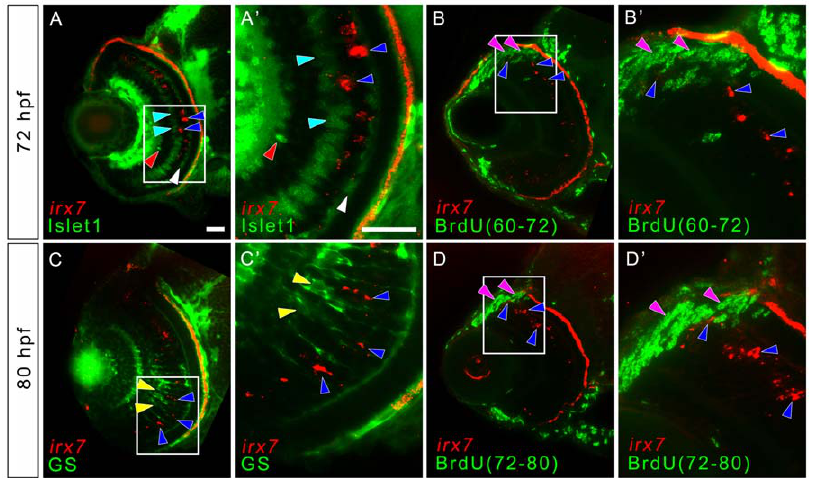
Figure 2. Irx7 expresses in non-proliferative cells that are likely to be undifferentiated precursors in mature retina. To detect for the co-localization of irx7 and ACs, BCs, HCs, MCs and proliferative cells in the more differentiated part of the WT retina, in situ hybridization of irx7 was conducted in conjunction with immunostaining of anti-Islet1 for ACs, BCs and HCs, anti-GS for MCs and anti-BrdU for proliferative cells. (A) irx7 in situ hybridization with anti-Islet1 immunostaining at 72 hpf. The blue arrowheads indicate the irx7 + cells (red colour) in the retina, while the red, cyan and white arrowheads indicate ACs, BCs and HCs respectively (all in green colour). (A 9 ) The magnified view of the white box in (A). (B and D) The retina of embryos treated with BrdU from 60 to 72 hpf and 72 to 80 hpf respectively. The blue arrowheads indicate irx7 + cells (red colour), while the pink arrowheads indicate BrdU + cells (green colour). (B 9 and D 9 ) The magnified view of the white box in (B and D) respectively. (C) irx7 in situ hybridization with anti-GS immunostaining at 80 hpf. The blue arrowheads indicate the irx7 + cells (red colour), while the yellow arrowheads indicate MCs (green colour). (C 9 ) The magnified view of the white box in (C). Lateral is to the left and dorsal is up for all sections. Note that the RPE layer also showed red fluorescence but that was not a real signal. It was an artifact of the pigmentation in RPE. Since the images of the in situ hybridization were inverted before combining with the fluorescent images obtained from the immunostaining, the darker pigment in RPE, as well as the intense in situ colour, would appear as signal in this transformation. Scale bars=20 m m.